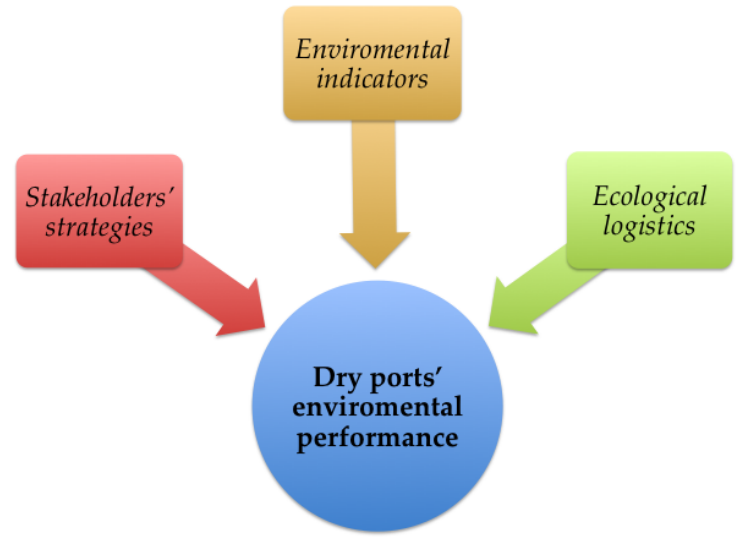
Figure 5. Conceptual framework and its variables derived from the SLR. Source: personal elaboration by the